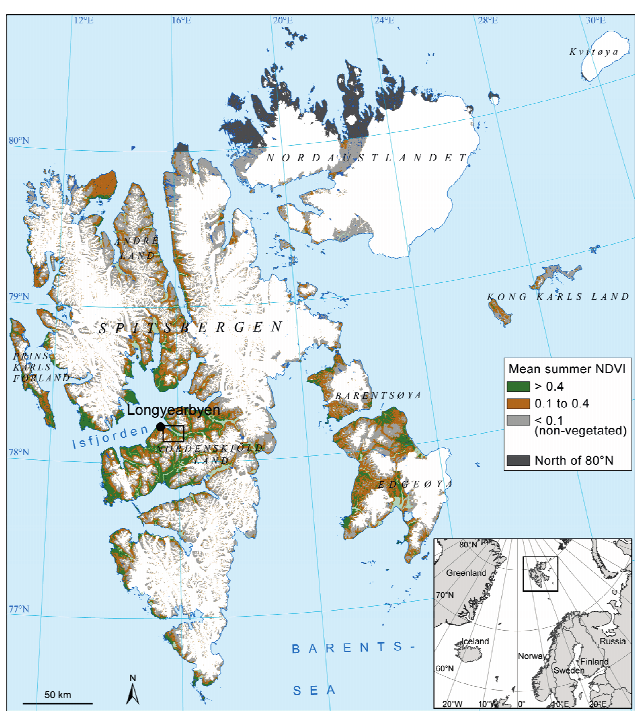
Figure 1. Study area of Svalbard showing cloud-corrected MODIS-NDVI values for the period 4 July to 3 August (“summer NDVI”), mean for the 2000–2013 period. The location of the area with field observations of the growing season is shown by a rectangle southeast of